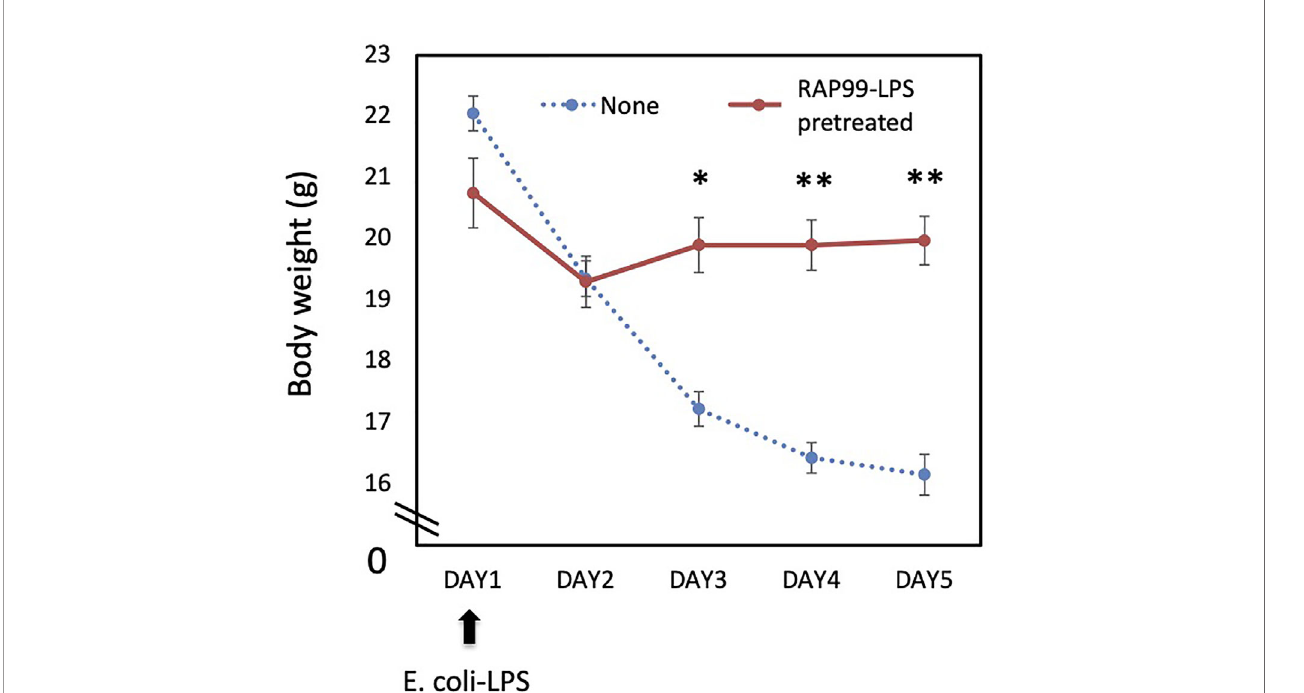
FIGURE 2 | RAP99-LPS pretreatment suppressed E. coli -LPS-mediated body weight loss. RAP99-LPS (200 m g/day) or saline was intraperitoneally injected into C57BL/6 mice daily for 5 days followed by the injection of E. coli -LPS (200 m g) on day 1 to investigate body weight. Mean scores ± SD are shown. *p < 0.05, **p < 0.01; Student ’ s t tests. (n = 5 each, Representative data are